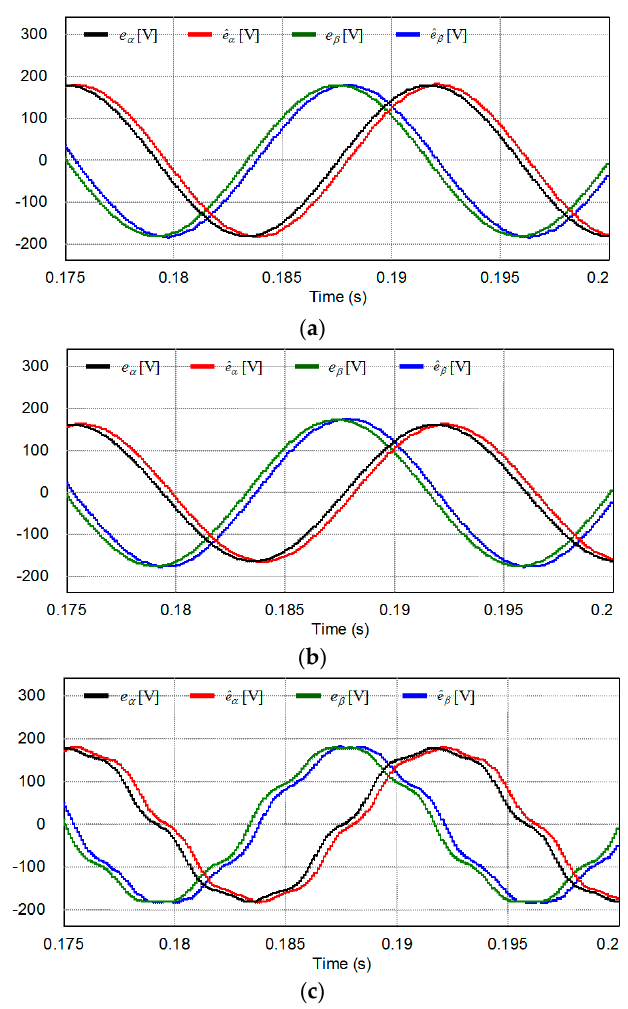
Figure 14. Estimation of grid voltages using the conventional linear Luenberger type disturbance observer. ( a ) Under the ideal grid voltages; ( b ) under unbalanced grid voltages; and ( c ) under harmonic distorted grid voltages.